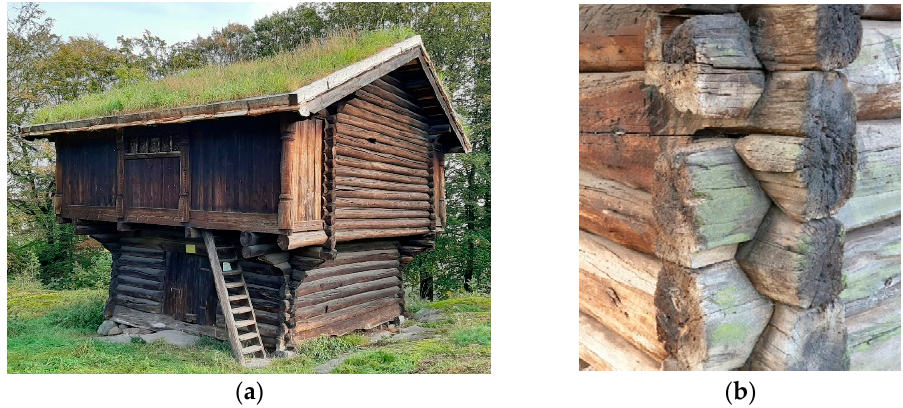
Figure 3. ( a ) A heritage log house building in Tønsberg, Norway. ( b ) Carpentry corner joint of the logs.